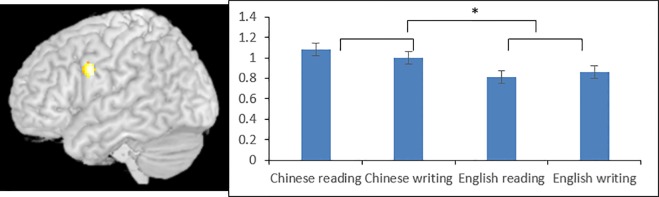
ROI analysis at the left middle frontal gyrus in the Chinese L1 group.Chinese L1 participants also showed greater activation for Chinese than for English at this ROI centered at (-50, 2, 28). * indicates significance at p < .05. Error bars indicate standard errors.